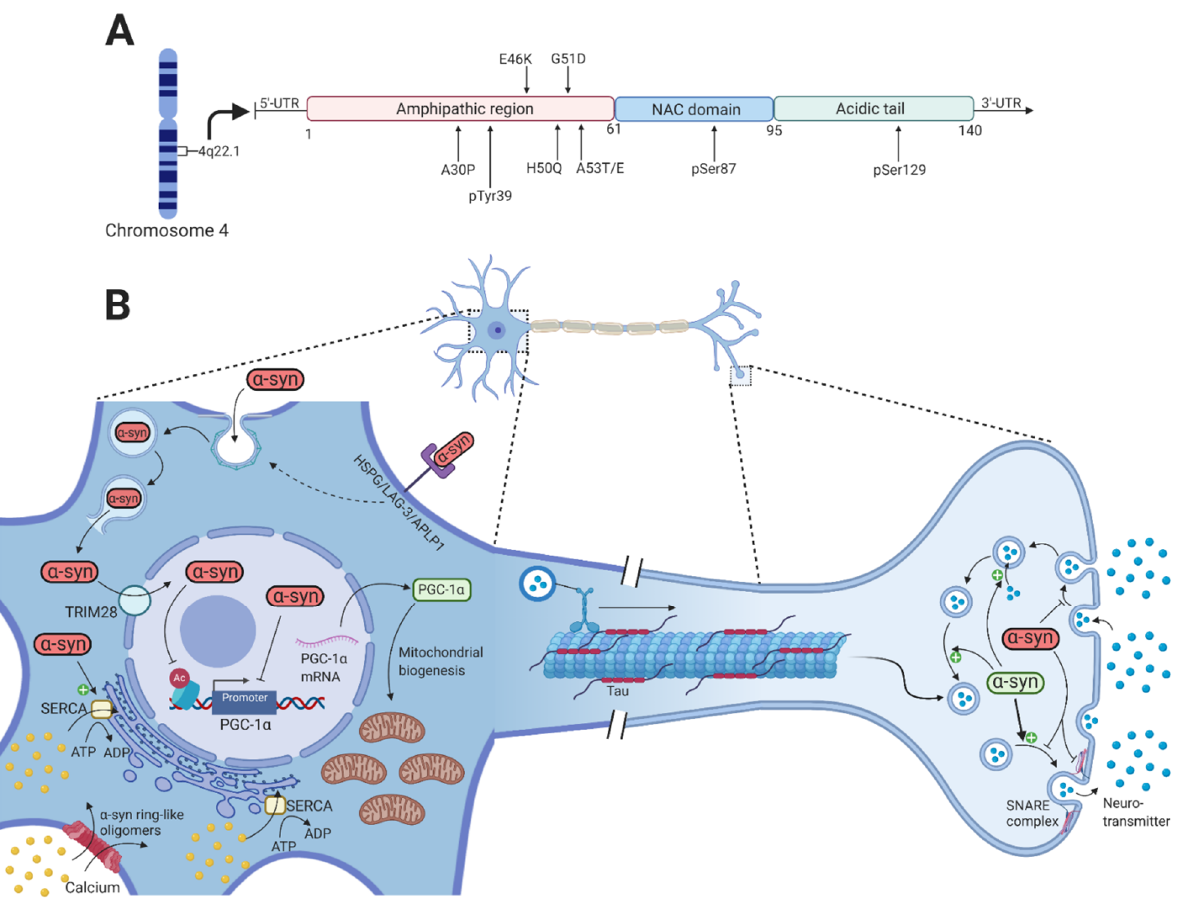
Figure 1. α -synuclein function and pathology. ( A ) Shows a schematic representation of α -synuclein on transcript level with color-coded functional domains and mutations of α -synuclein mentioned in this article. ( B ) Under physiological conditions, α -synuclein (green) is involved in the compartmentalization, storage, and recycling of neurotransmitters. It also contributes to the exocytotic process by promoting SNARE-complex assembly, thereby enabling the fusion of intracellular presynaptic vesicles with the presynaptic membrane. Neurotoxic alterations of α -synuclein (red) by missense mutations in the SNCA gene, gene duplication or triplication, and various PTMs increase the formation of toxic oligomers and fibrils that disrupt intracellular processes. The internalization of toxic α -synuclein is through dynamin-mediated endocytosis and cell surface protein-mediated uptake through HSPG, LAG-3, and APLP1. Inside the endosome, α -synuclein is able to rupture the membrane to allow direct entry to the cytosol. α -synuclein oligomers can permeabilize the plasma membrane by creating pore-like structures, thus increasing the cytosolic calcium concentration. Activation of the SERCA pump by these oligomers will later contribute further to the increased cytosolic calcium. Through TRIM28, toxic α -synuclein accumulates inside the nucleus where it binds and inhibits the PGC-1 α promoter and reduces histone H3 acetylation, potentially affecting numerous cellular processes. This results in reduced PGC-1 α mRNA and protein, which reduces mitochondrial biogenesis. Created with BioRender.com.